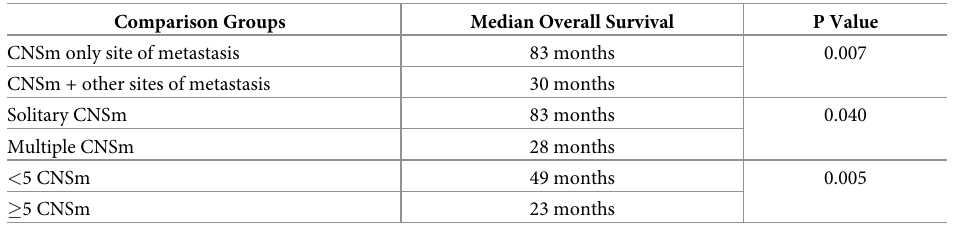
Table 3. Differences in overall survival based on number of CNSm and disease